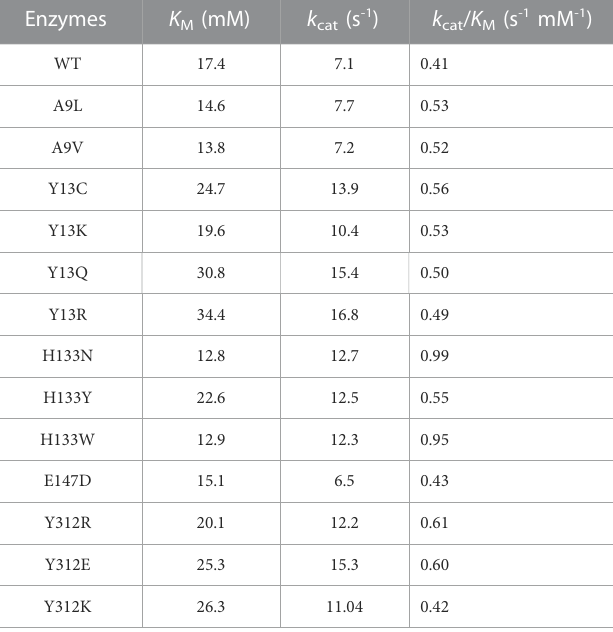
TABLE 2 The conversion and de value of positive variants produced in SM and